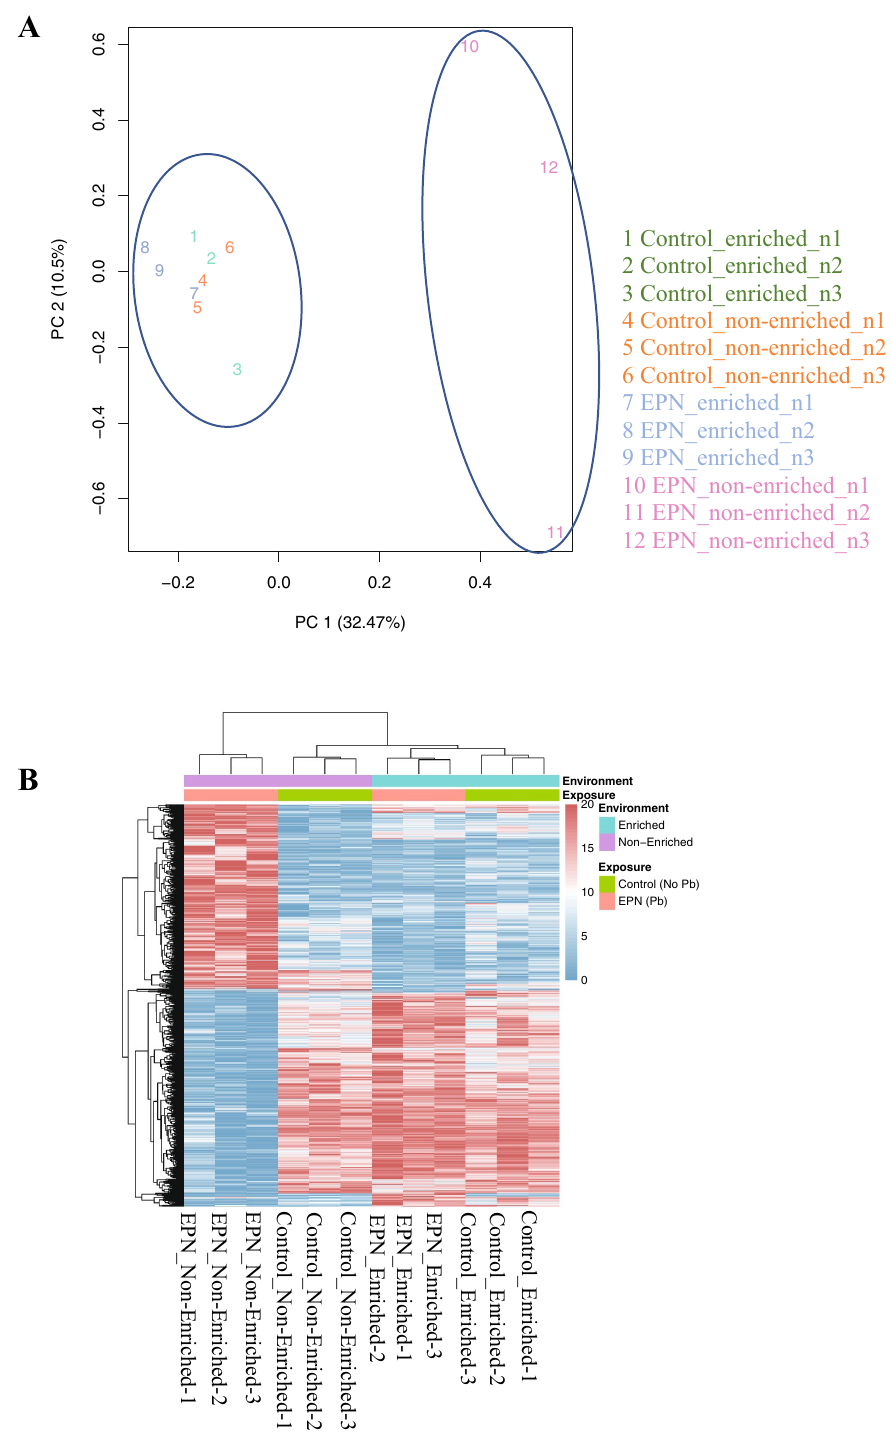
Figure 2. Principle component analysis (PCA) and hierarchical clustering of HIPP CA1 RNA-seq data. ( A ) PCA analysis across all samples and treatment conditions, based on overall gene expression profiles, shows EPN_non-enriched animals clustered in a distinct group compared to the other groups (Control_non-enriched, Control_enriched and EPN_enriched). ( B ) Heatmaps generated from unsupervised clustering of genes with the highest variation across the dataset show effects of Pb exposure and enrichment on gene expression patterns (FDR < 0.05, one-way ANOVA across all the treatment groups, see Supplementary Material 5). Transcriptomic changes in the EPN_non-enriched groups were distinct from those in the Control_(enriched or non-enriched) and EPN_enriched groups, while the heatmaps from EPN_enriched and Control_(enriched or non-enriched) animals were quite similar. N = 3 per